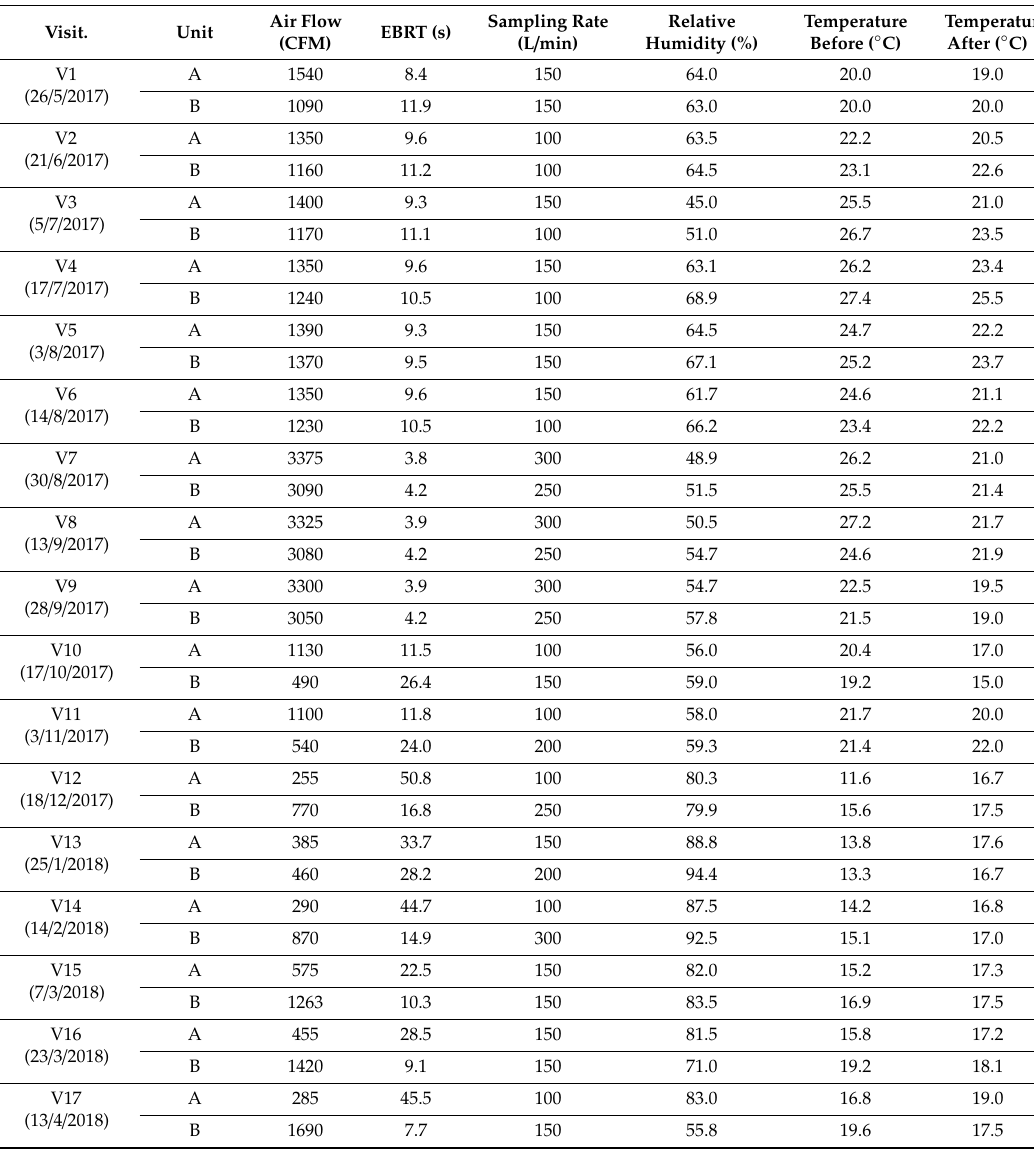
Table 2. Table of recorded air treatment unit (ATU) environmental conditions during sampling. This table includes the approximate air flow (cubic feet per minute) within the ATU and the sampling rate selected based on isokinetic calculations. Relative humidity was only measured before the ATU and was assumed to be near 100% at the